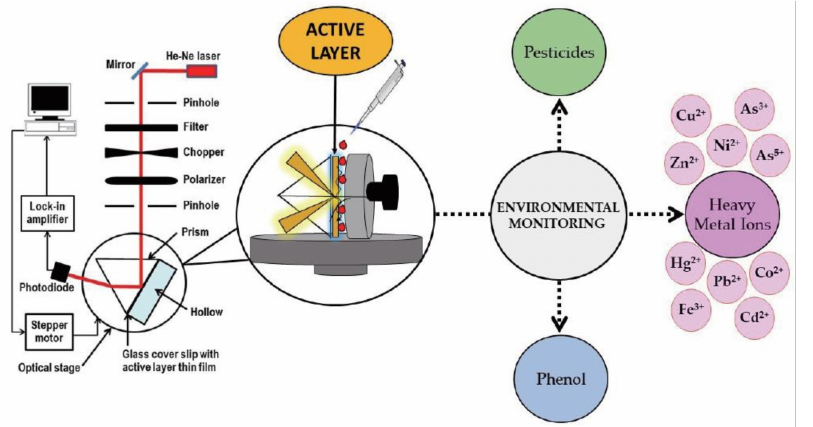
Figure 7. Schematic representation of an SPR optical sensor for phenol and pesticide detection in environmental applications. (Reprinted from [39] under Open Access